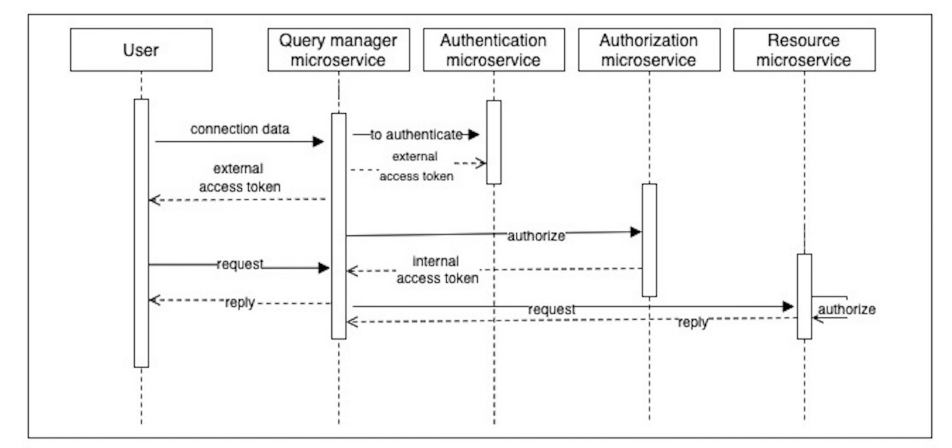
Figure 2. UML sequence diagram of the generalized process for centralized access control in microservices.